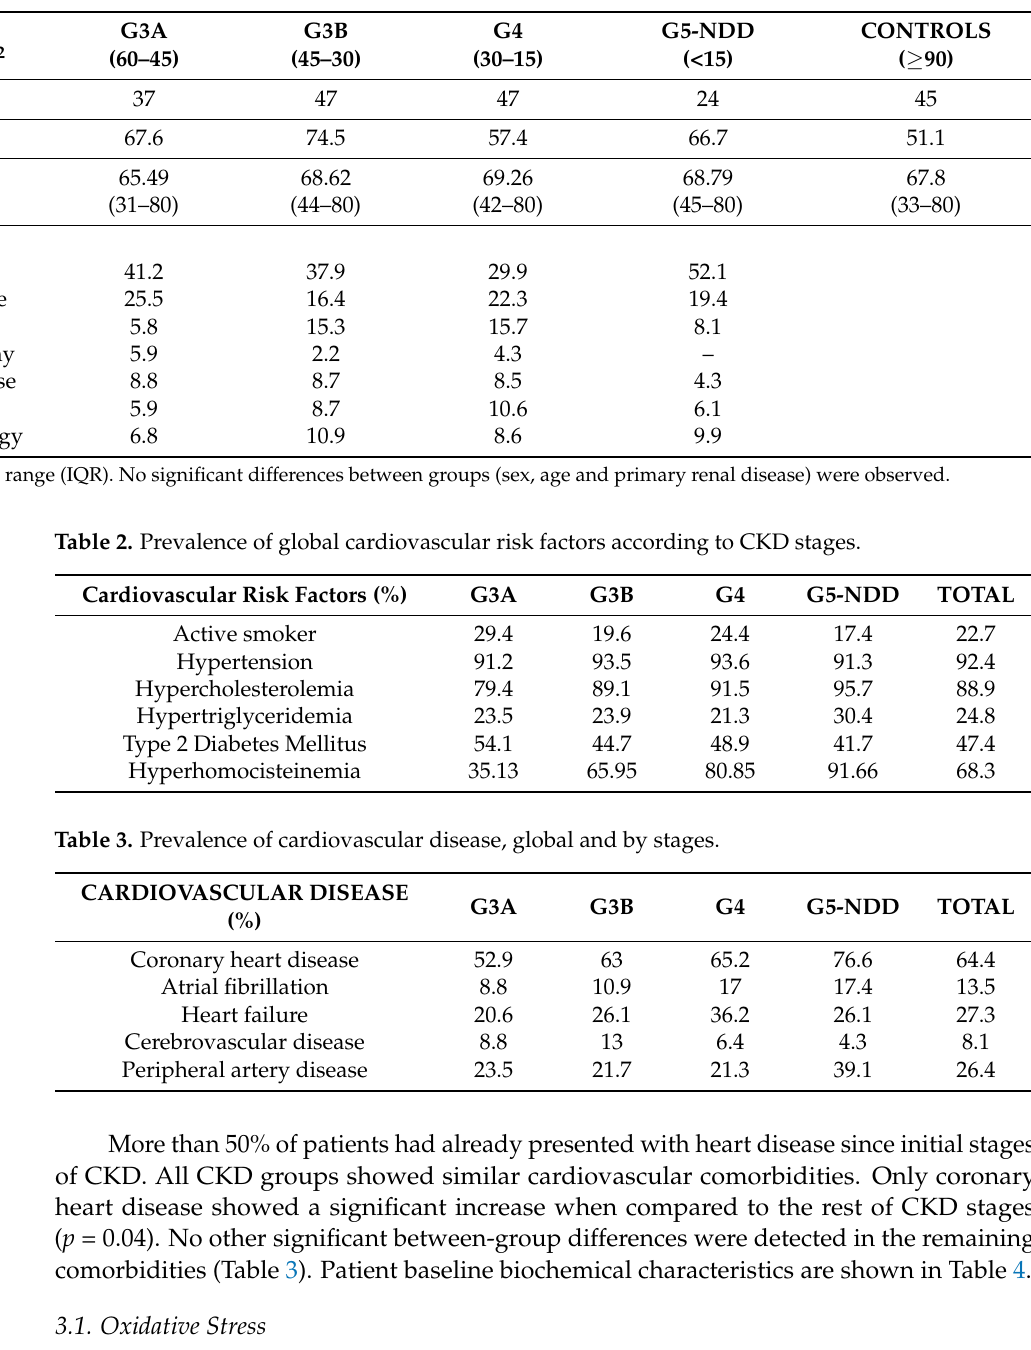
Table 1. Baseline characteristics, demographic data and primary cause of CKD.